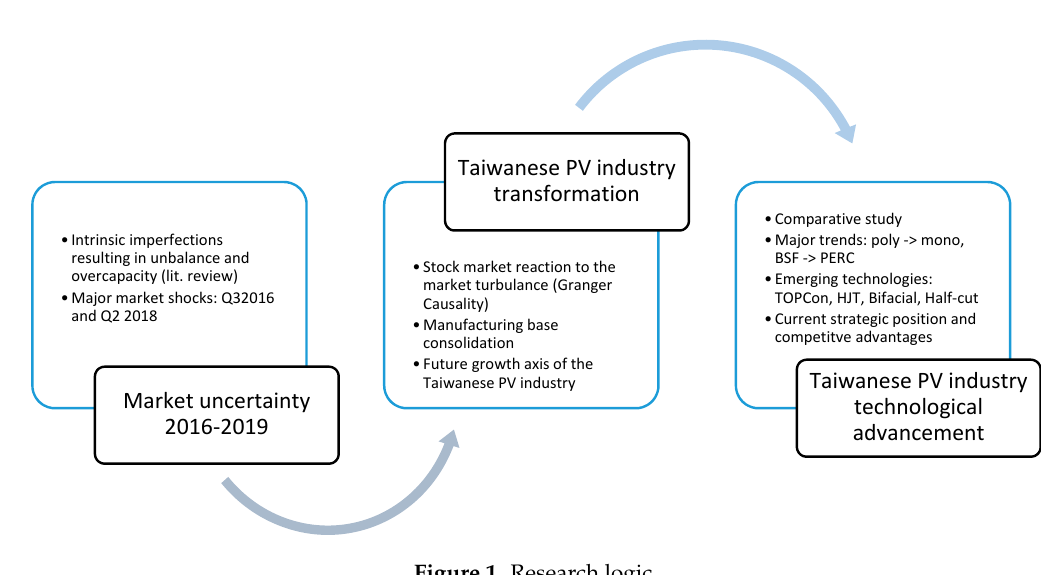
Figure 1. Research Figure 1. Research logic.